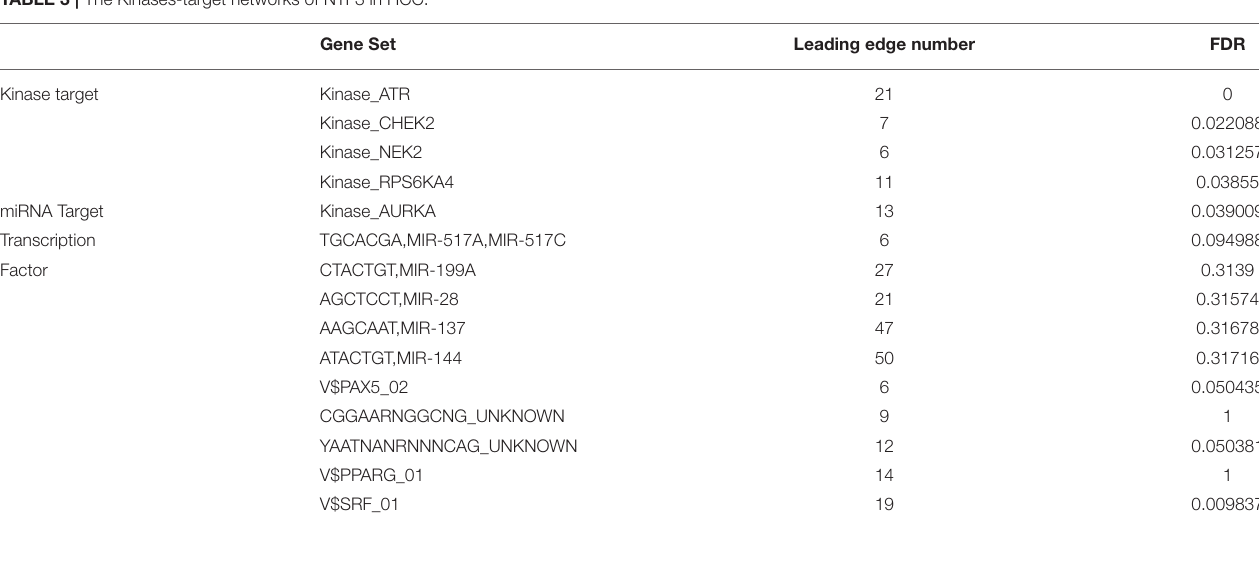
TABLE 3 | The Kinases-target networks of NTF3 in